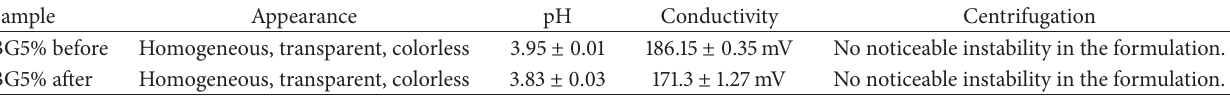
Table 1: Results of evaluation of the preliminary stability of borneol gel 5% before and after the freeze-thaw cycle. Sample Appearance pH Conductivity Centrifugation 3.83 ± 0.03 171.3 ± 1.27 mV